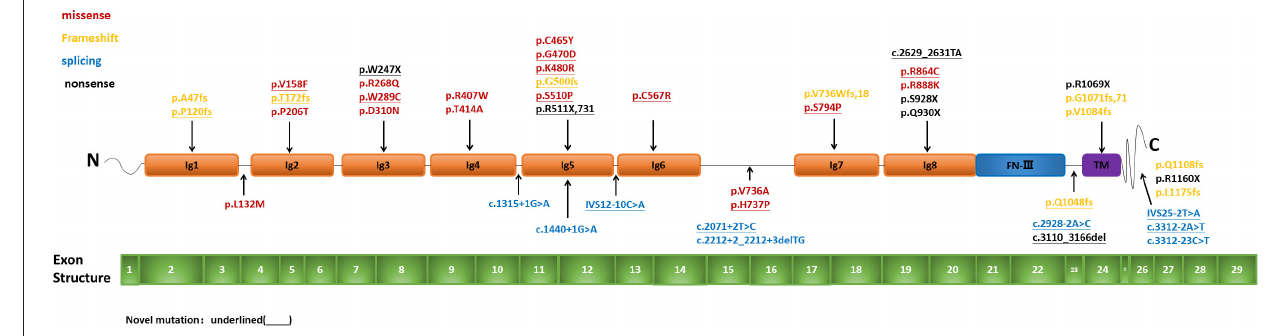
FIGURE 1 | Pattern of variant(s) in the NPHS1 gene: Exon structure of the NPHS1 gene and the location of the variants identified in the present study.